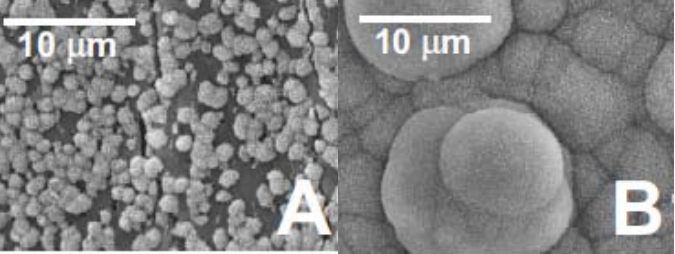
Figure 10. SEM images of different substrates after immersion in SBF for two weeks at ( A ) 25 °C and ( B ) 37 °C. Set 1 corresponds to PNIPAA-grafted PLLA films with 20% bioactive glass particles. The thermoresponsiveness of the particles is demonstrated by the selective growth of apatite after increasing the temperature. Reproduced from [34] with permission from John Wiley and